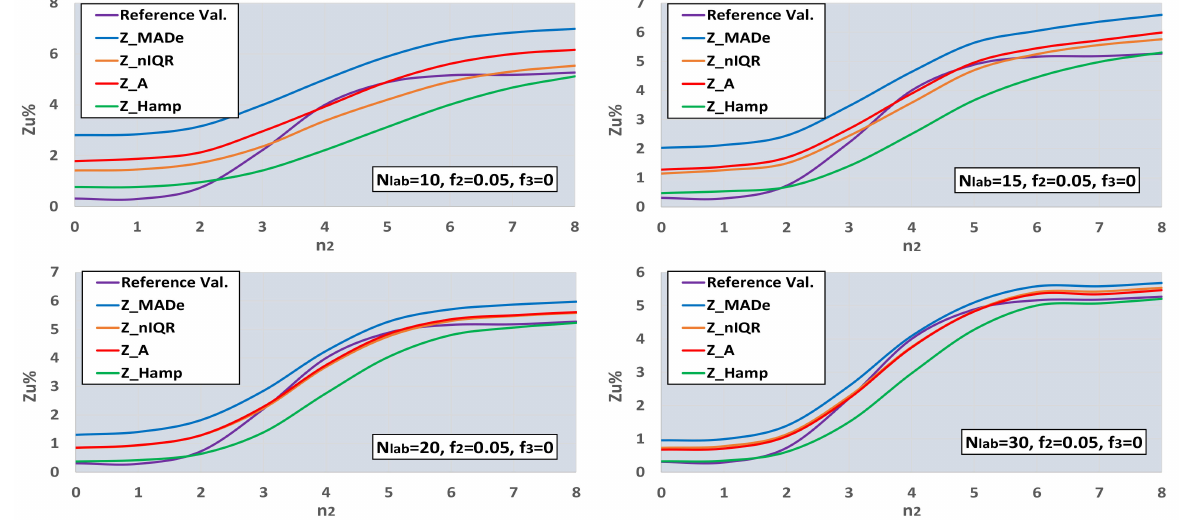
Figure 9. Functions between Zu% and number of standard deviations n 2 , for the reference values and robust estimators, and N lab = 10, 15, 20, 30.